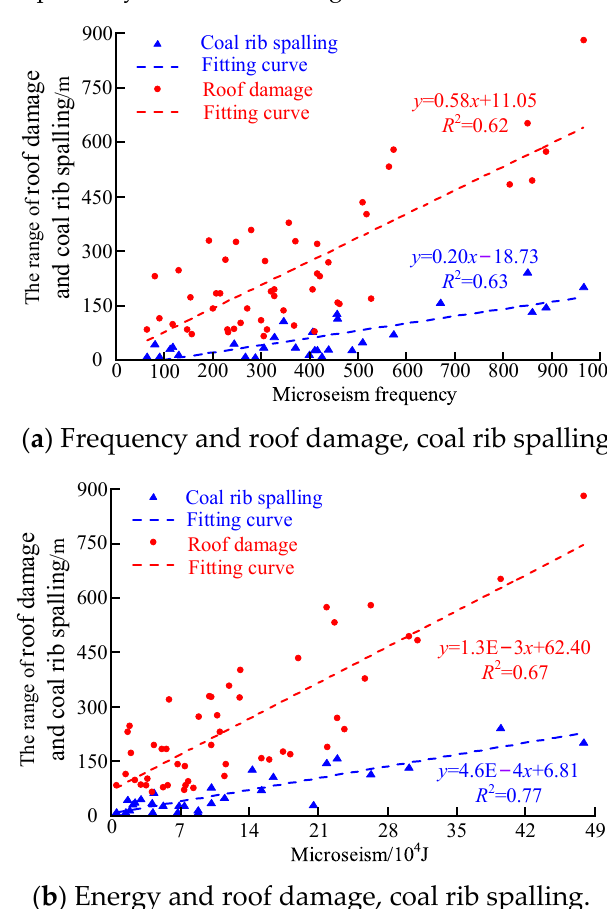
Figure 6. The spatial distribution of microseism energy and frequency in the inclination direction.